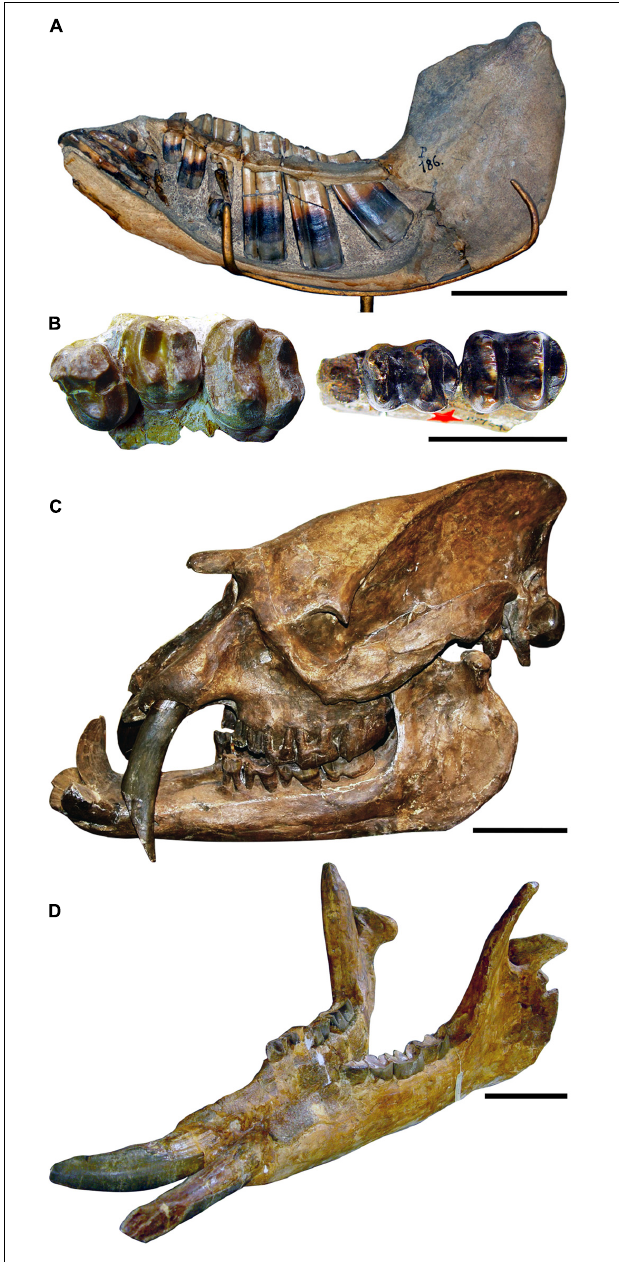
FIGURE 4 | Some evolutionary traits of Sudamericungulata lineages. (A) Left hemimandible of a notoungulate toxodontid showing hypselodonty (ever-growing cheek teeth) in lateral view. Note the teeth with open roots. Photograph courtesy by D. Croft, and reuse permitted under CC BY-NC-SA 2.0. (B) Left P4-M2 of the xenungulate Carodnia vieirai (on the left) and left dp4-m1 of the pyrothere Griphodon peruvianus Anthony, 1924 (on the right) showing the bilophodonty. Photograph courtesy of Carodnia vieirai by L. Bergqvist. (C) Skull of the astrapothere Astrapotherium magnum Owen, 1853, in lateral view. Note the ever-growing tusk-like canines, the absence of upper incisors, the retracted nasal opening, and the reduction of cheek teeth. (D) Mandible of the astrapothere uruguaitheriine Granastrapotherium snorki Johnson and Madden, 1997. Note its gigantic size, the absence of lower incisors, the tusk-like and protruded lower canines, and the extreme reduction of lower cheek teeth. Scale bar in (A , C , D) = 10 cm and in (B) = 5